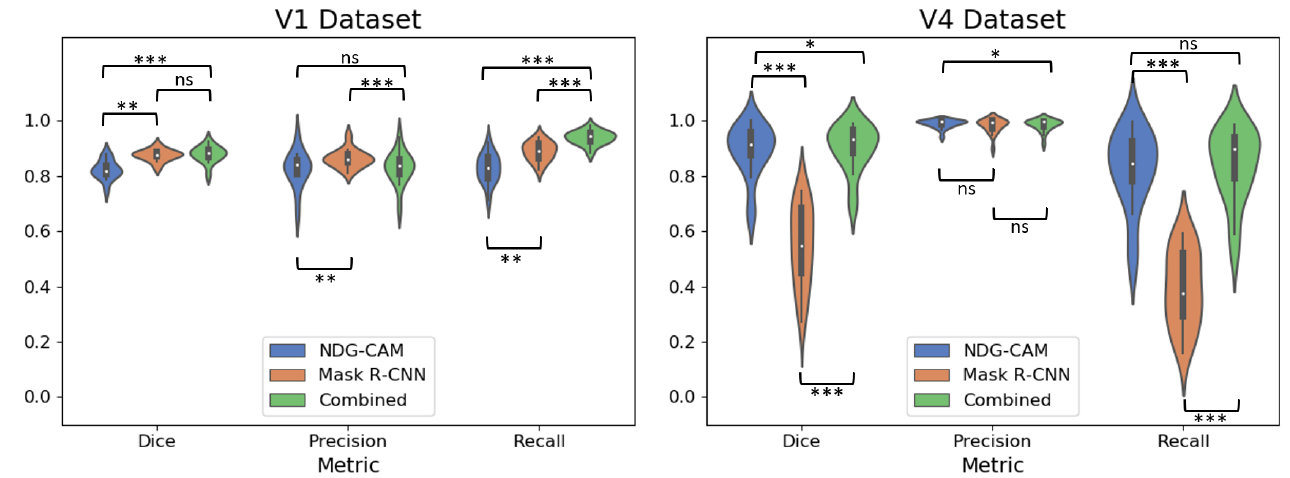
Figure 6. Violin plots for the detection metrics calculated per case. ( Left ) V1 dataset. ( Right ) V4 dataset. In the figure, ns stands for nonsignificant; * denotes p -value < 0.05; ** indicates p -value < 0.01; and *** means p -value <